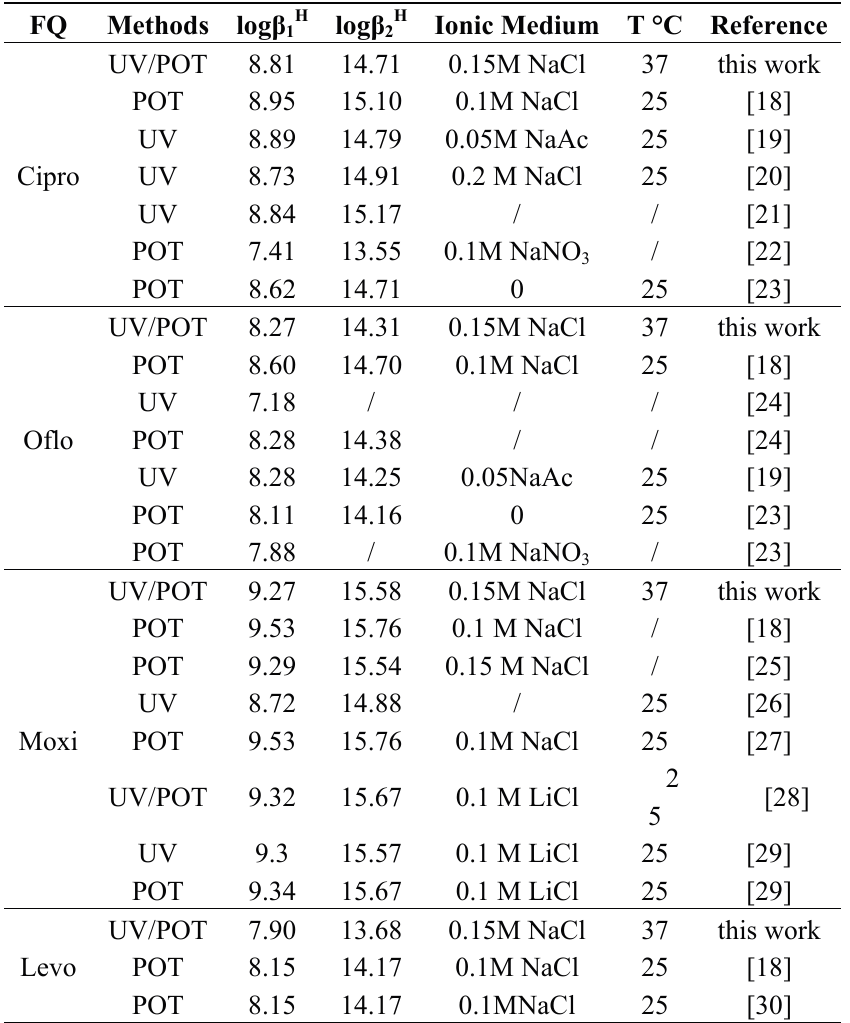
Table 2. Calculated protonation constants ( log β ± SD ) for fluoroquinolones compared with literature